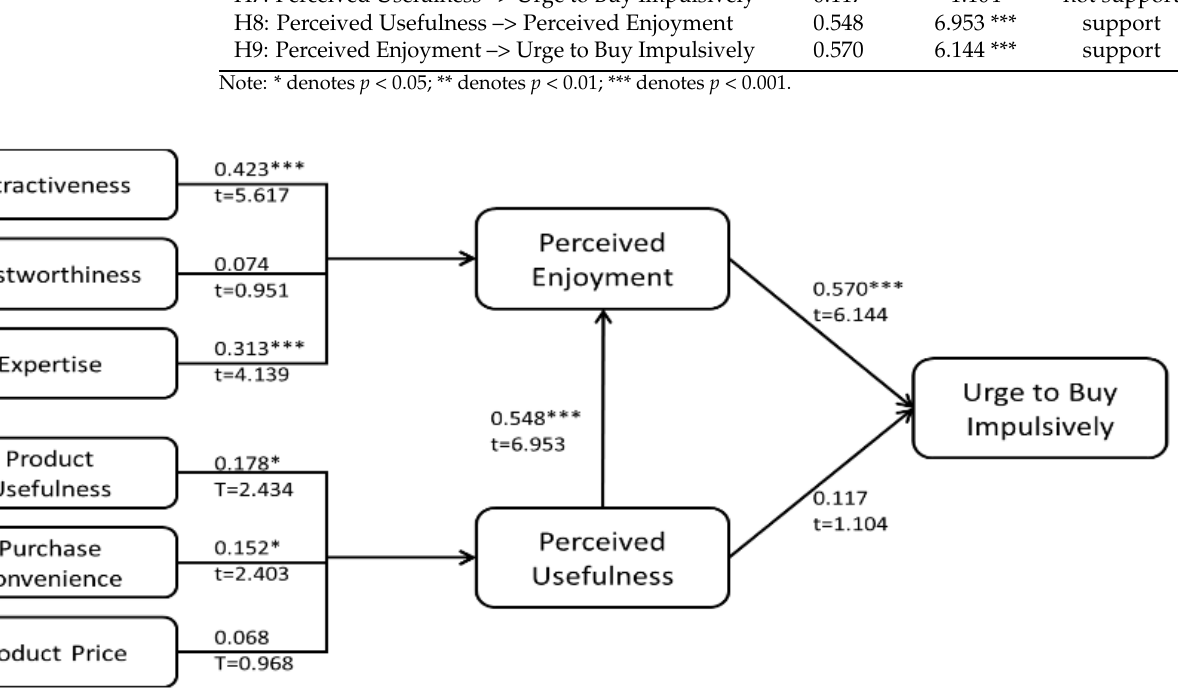
Figure 2. The results of the hypothesis test (*** p < 0.001, ** p < 0.01, * p <